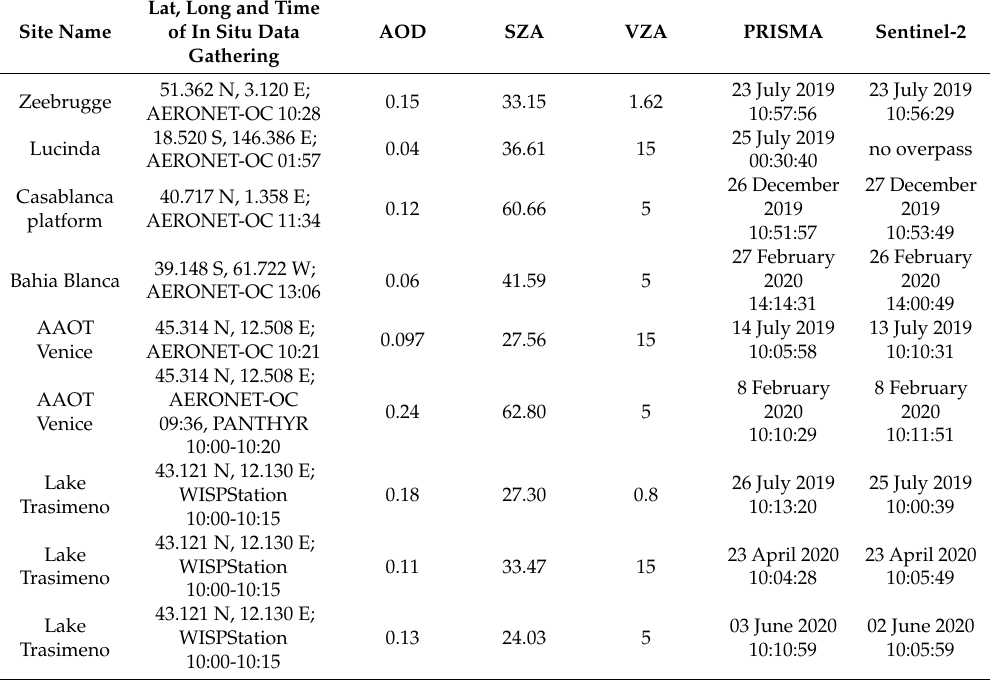
Table 2. Site names; coordinates (in decimal degrees) of in situ AERONET-OC, PANTHYR and WISPStation sensors with the time (hh.mm) of the measures used in the 6SV simulation (in case of WISPStation an average value in the defined range); aerosol optical depth at 550 nm (AOD) and Sun zenith angle (SZA in degree) at the sensing time of PRISMA; view zenith angle (VZA in degree) of PRISMA; dates and sensing times of PRISMA and